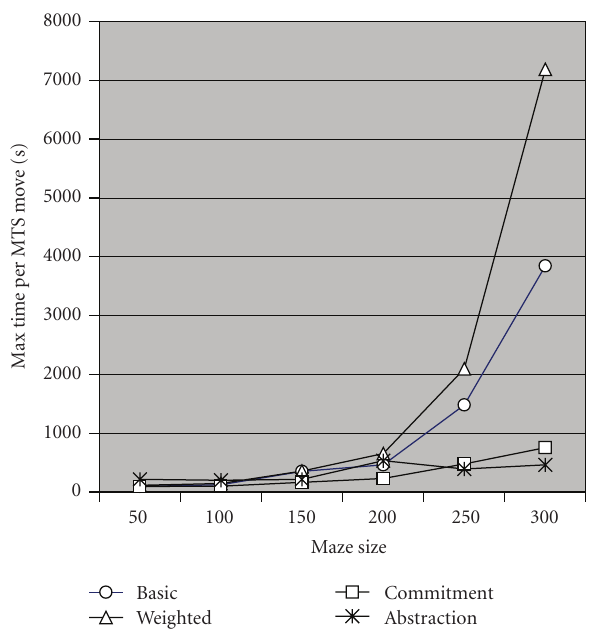
Figure 6: Maximum time per MTS